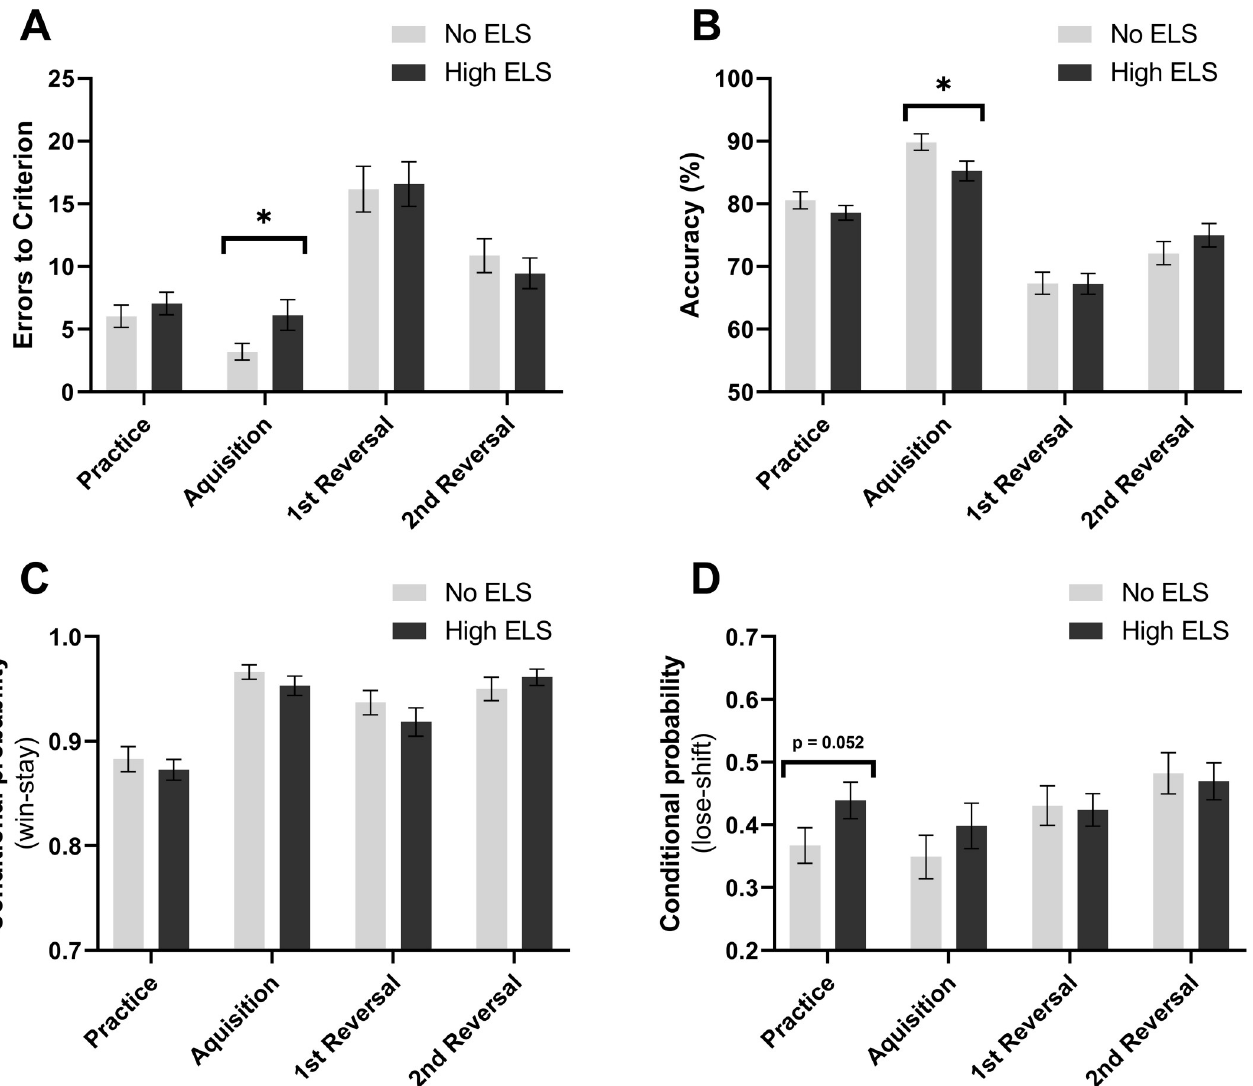
Fig 3. High ELS participants show impaired learning in the acquisition phase of block 1. (A) Errors made while reaching criterion for each phase, (B) accuracy within each phase, (C and D) win-stay and lose-shift probabilities for each phase of block 1 and practice respectively.